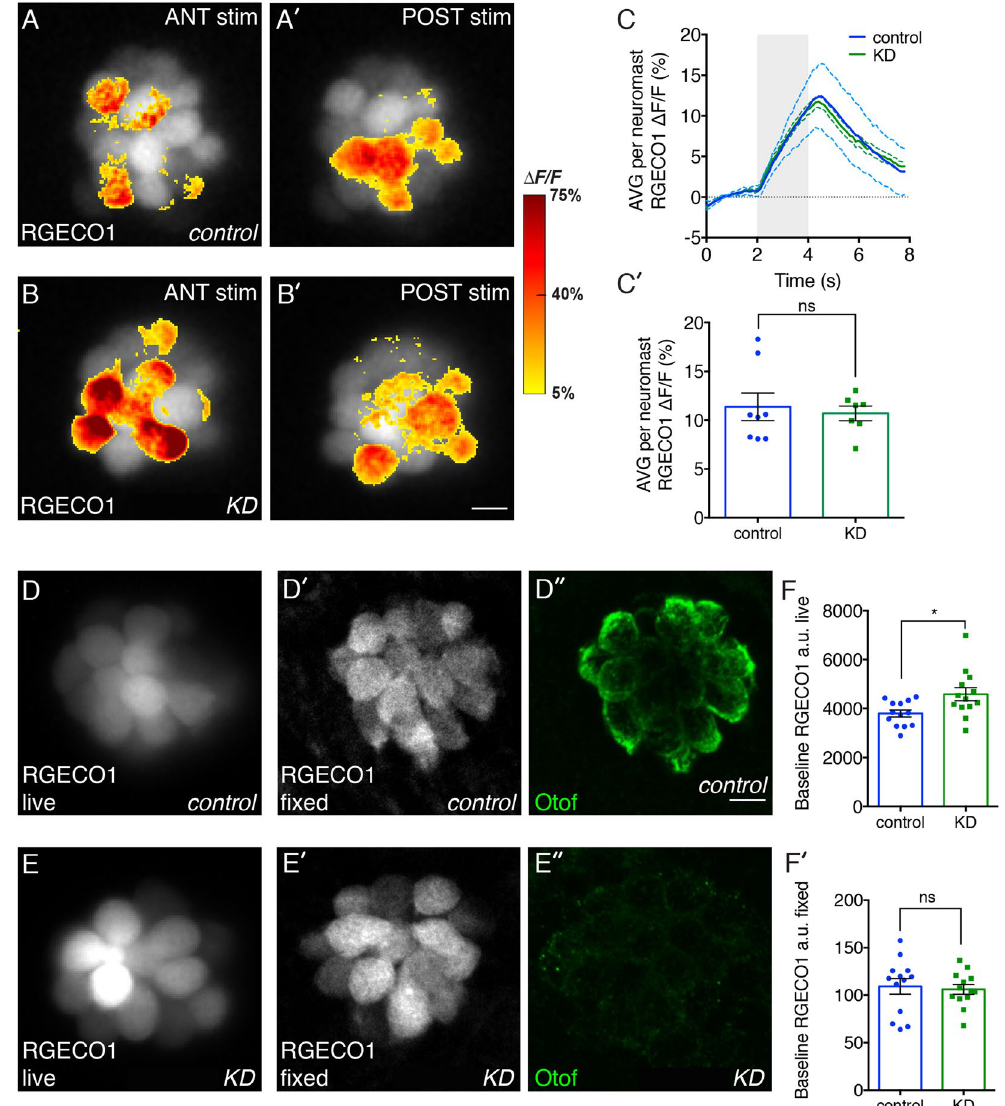
Figure 3. Effects of otoferlin depletion on intracellular calcium in posterior lateral line neuromasts. Representative evoked R-GECO1 calcium signals in negative control injected ( A – A ’) and otoferlin depleted ( B – B ’) neuromasts during mechanical stimulation of hair bundles. The ANT (anterior) and POST (posterior) responses reflect the two directions the posterior lateral-line neuromasts are mechanically sensitive. Calcium signals during stimulation ( A – A ’ and B – B ’) are colorized according to the heat map and superimposed onto baseline images. ( C , C ’) The magnitude of the mechanically-evoked R-GECO1 calcium responses were not significantly altered between control and otoferlin depleted neuromasts, t-test p = 0.70, n = 8 control and 7 KD neuromasts. ( D , E ) The live, R-GECO-1 baseline intensity in otoferlin depleted hair cells was significantly elevated compared to controls ( D – F ) t-test, p = 0.016. In the same samples as ( F ), the fixed, R-GECO1 levels ( D ’, E ’) were not significantly different in otoferlin depleted hair cells compared to controls ( F ’), t-test, p = 0.745, n = 13 neuromasts. ( D ”, E ”) Samples were also immunostained with HCS-1 (Otof) to ensure depletion was effective. Scale bars = 5 µ